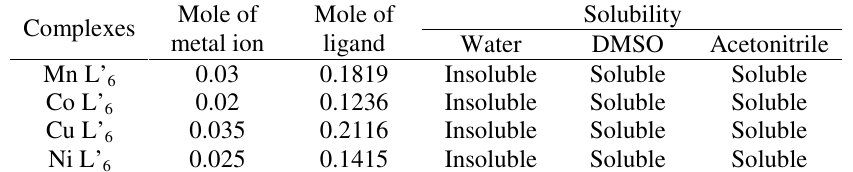
Table 1 . Stoichometric composition and solubility of synthesized complexes.